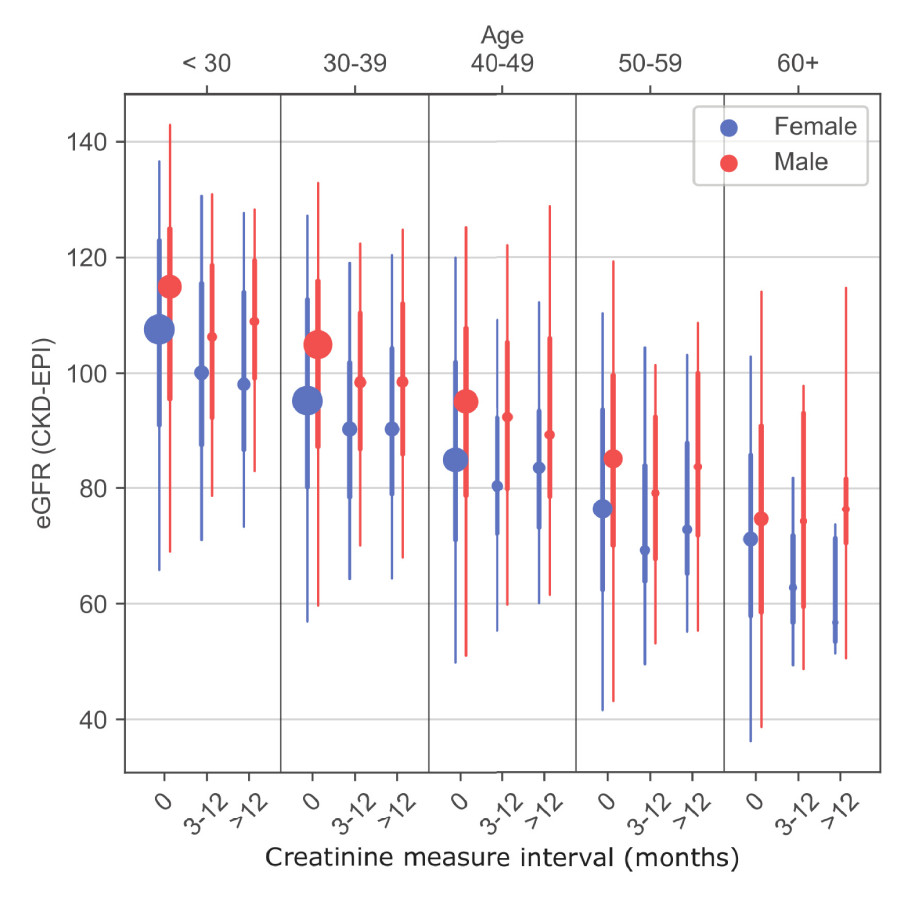
Fig 3. Repeated estimated glomerular filtration rate measures by sex and age. Notes: Marker size proportional to population size in each category.